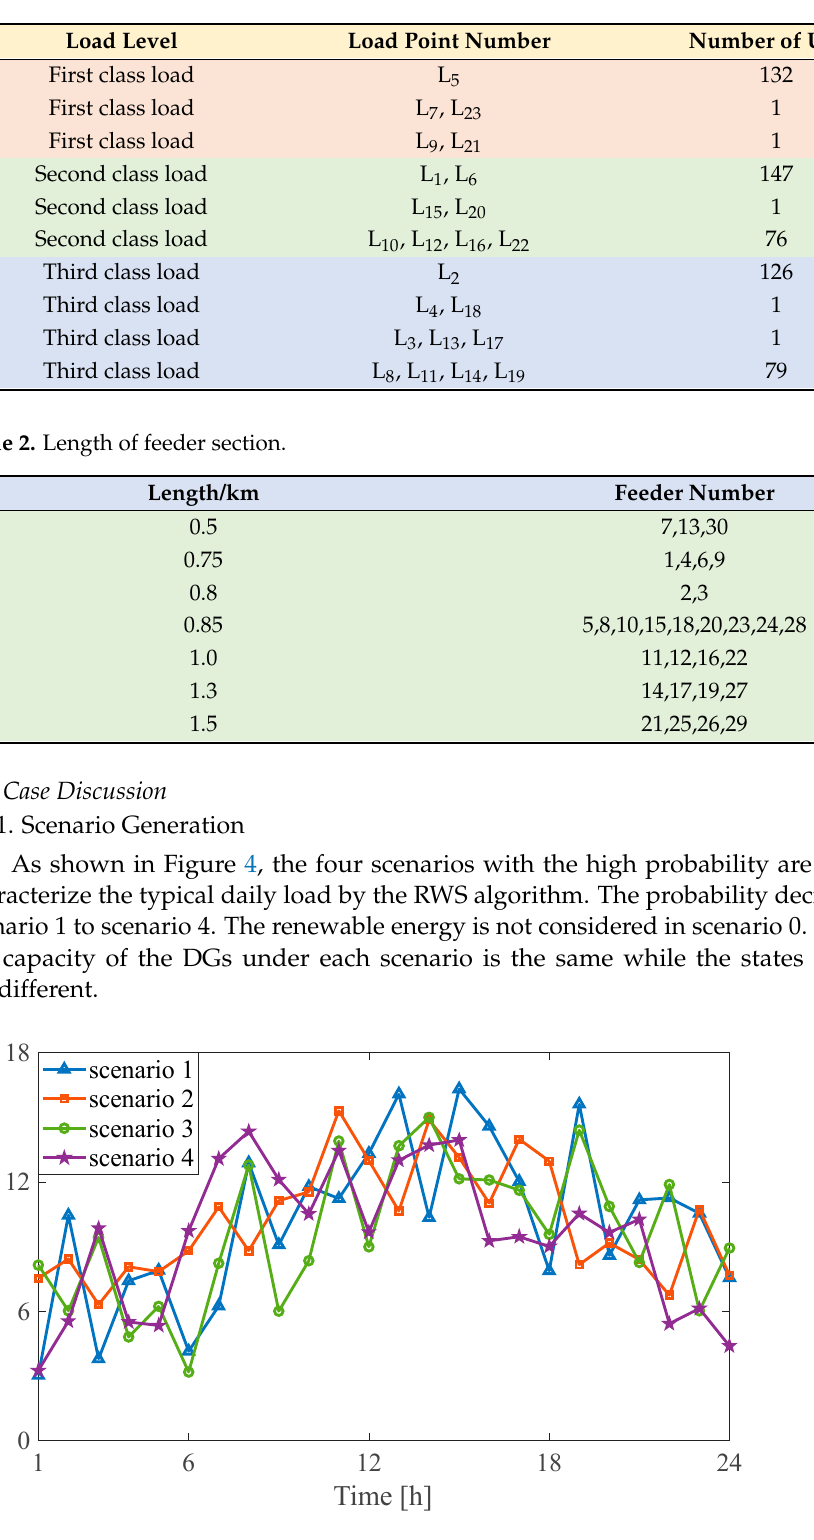
Table 1. Load data.